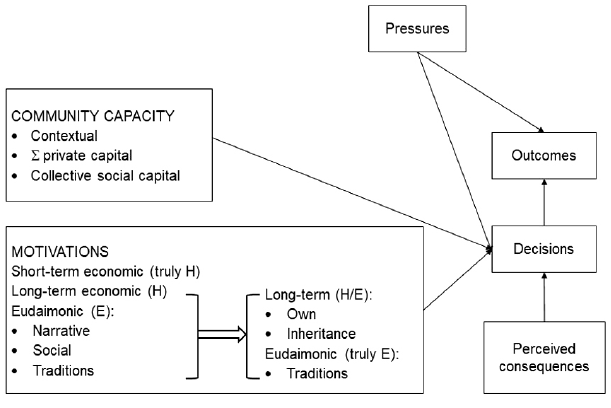
Fig. 2 . Conceptual